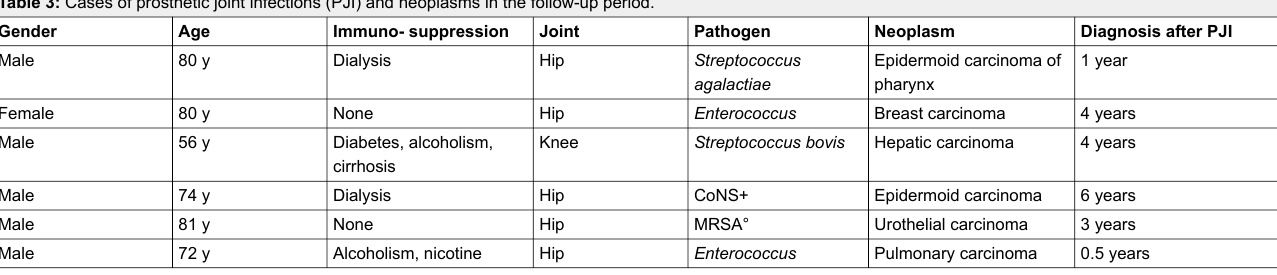
Table 3: Cases of prosthetic joint infections (PJI) and neoplasms in the follow-up period.